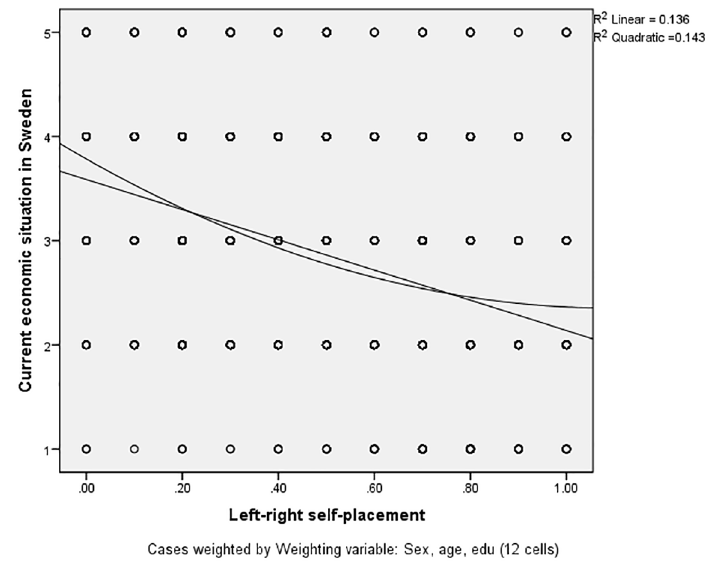
Figure 9. Linear and quadratic relationship between political ideology and negative sociotropic economic